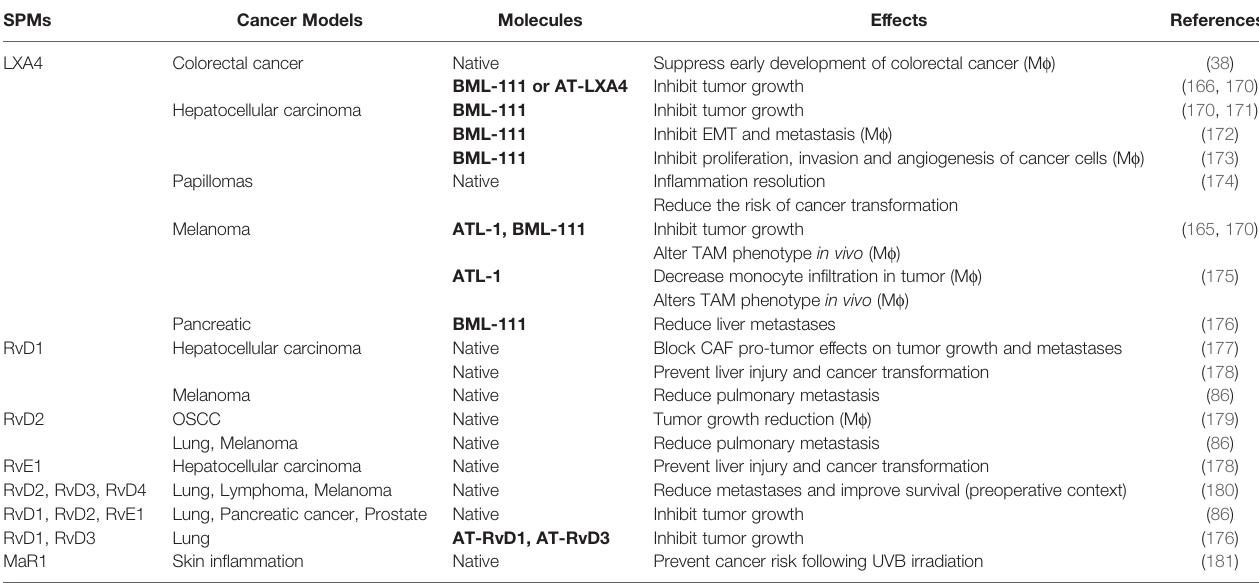
TABLE 3 | List of publications reporting SPMs ’ antitumor activity in murine cancer